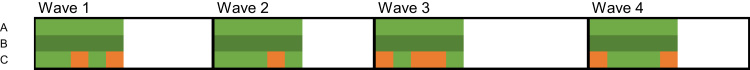
Examples of patterns of no change. Each horizontal line is an individual. The waves are separated by vertical black lines. Each trip is one square, individually colour-coded and the length of the line corresponds with the number of commute trips made over one week. Each colour represents one modal combination. Orange = car only; green = bicycle only; blue = walk only; yellow = train only; and brown = bus only. The white colour indicates no trip was made. Full legend: see Appendix D. (For interpretation of the references to color in this figure legend, the reader is referred to the web version of this article.)